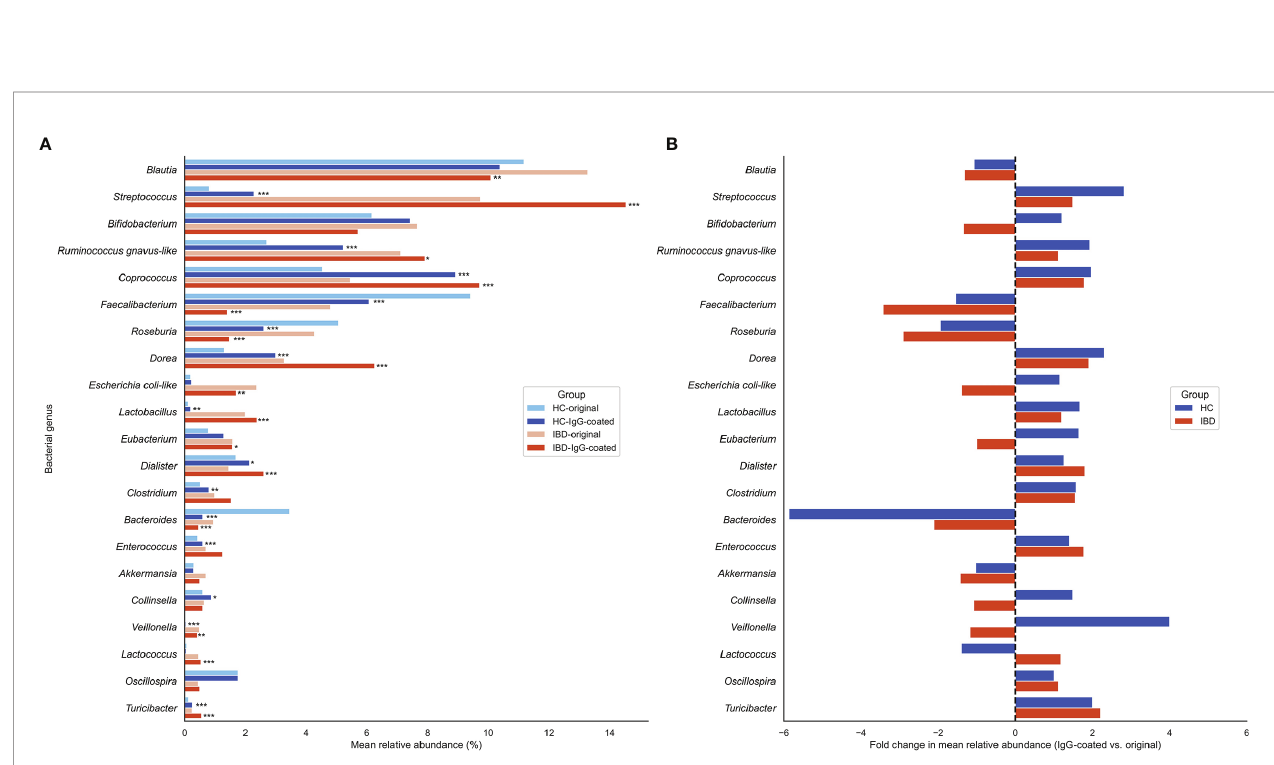
FIGURE 3 | (A, B) Changes in relative abundances of fecal bacterial genera before and after IgG-coating in patients with IBD and HC. (A) Changes in mean relative abundances (%) after IgG-coating in fecal samples of patients with IBD (orange) and HC (blue). (B) Fold changes in mean relative abundances (%) before and after IgG-coating in IBD (orange) and HC (blue). Fold changes represent coating indices and were computed as follows: relative abundance (IgG-coated)/relative abundance (untreated). Relative increases in bacterial abundances are depicted on the right side of the plot, whereas decreases are displayed on the left side of the plot. Bacterial genera with relative abundances >0.25 were taken into statistical analysis. (*) indicate statistically signi fi cant increases or decreases in bacterial abundances: * P < 0.05; ** P < 0.01; *** P < 0.001. HC, healthy control; IBD, in fl ammatory bowel